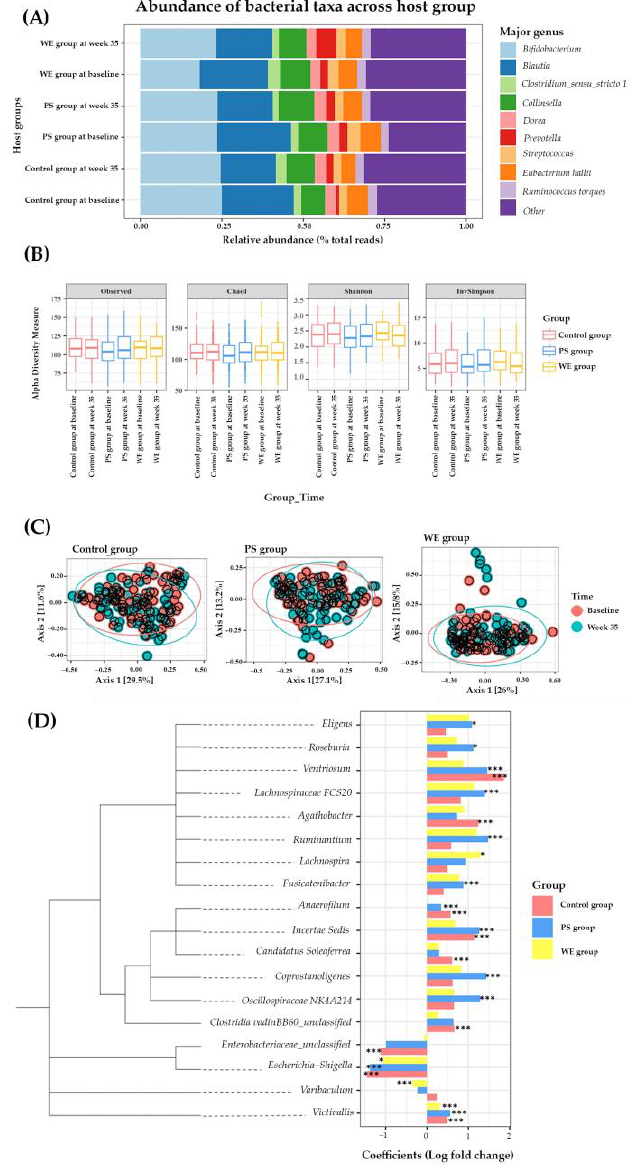
Figure 3. Microbiome change in study group. ( A ) Taxonomy classification. ( B ) Alpha diversity observed in different time points among the host group. ( C ) Multidimensional scaling plot of beta diversity described by Permutational multivariate analysis of variance (PERMANOVA) and the Bray-Curtis dissimilarity measure. ( D ) Differential abundances of bacteria and data are represented by effect size (log fold change of T3/T1) and 95% confidence interval bars (two-sided; FDR adjusted) derived from the ANCOM-BC model. All effect sizes with adjusted p < 0.05 are indicated, * p < 0.05; *** p < 0.001 of significance. Abbreviations; PS = protein substitute group; WE = whole egg